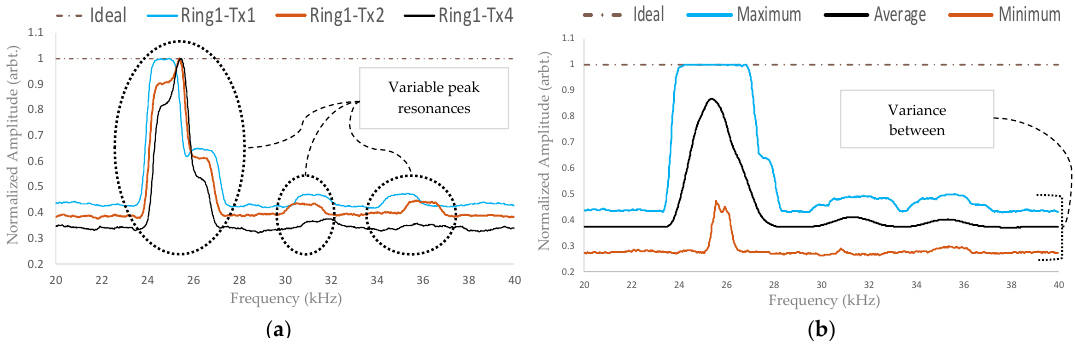
Figure 7. Example of designed transfer functions wherein ( a ) three different source points are compared and ( b ) the maximum, average, and minimum amplitudes across all of the applied transfer functions used in an individual test are shown.